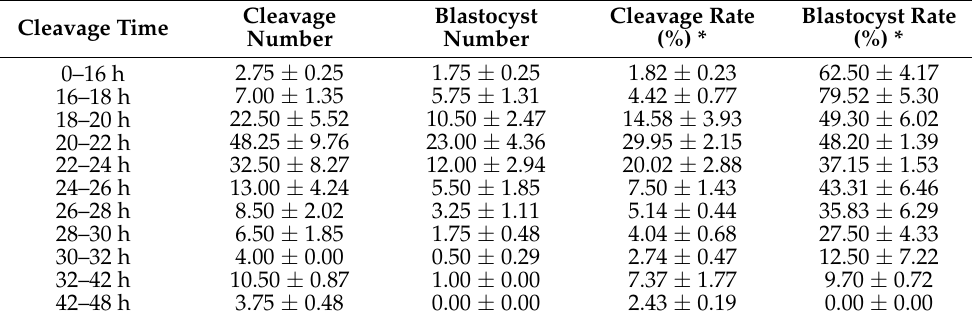
Table 1. The effect of cleavage time on statistics of cleavage time of PA